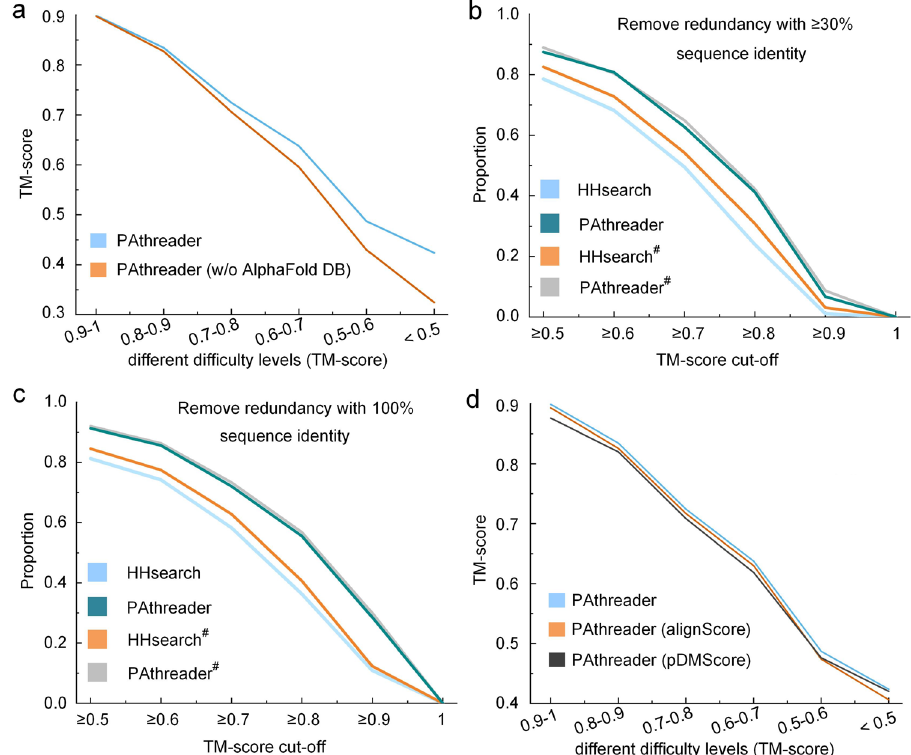
Fig. 3 Performance of PAthreader for template recognition. a The average TM-score for template recognition with and without AlphaFold DB at different cut-off ranges. b , c The proportion of the number of templates with ≥ 30% and 100% sequence identity removed at different TM-score cut-off. PAthreader # and HHsearch # represent the results obtained by comparing the identi fi ed structure with the native structure through TM-align. d The average TM-score for different template rankings, showing the effect of pDMScore on template